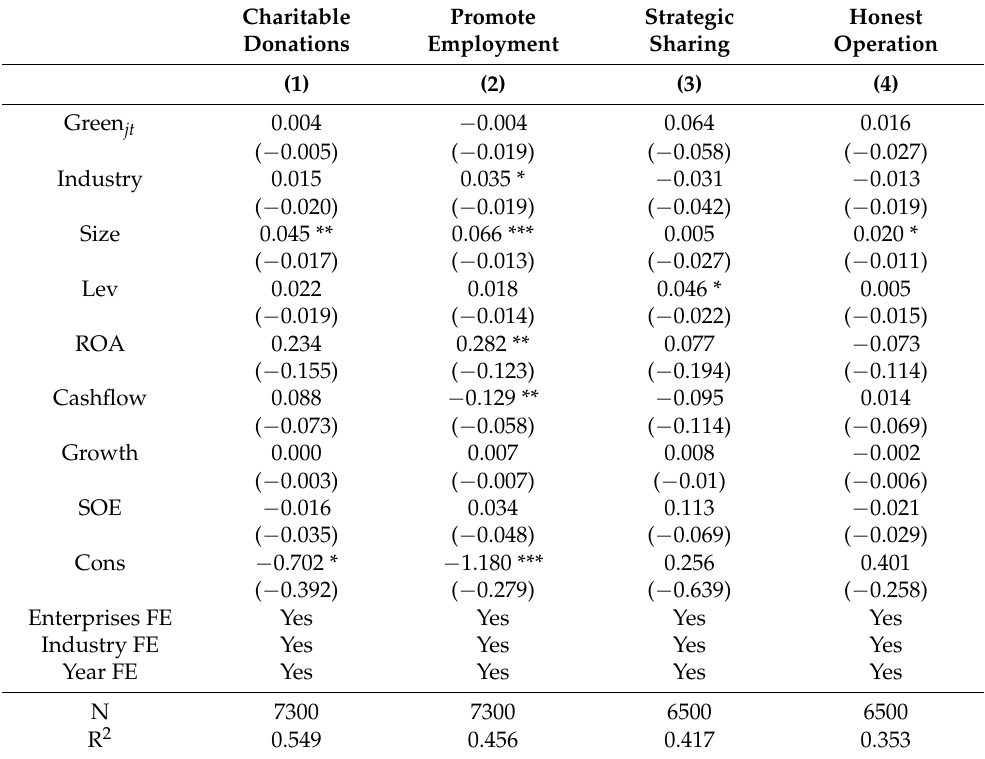
Table 5. Placebo test.